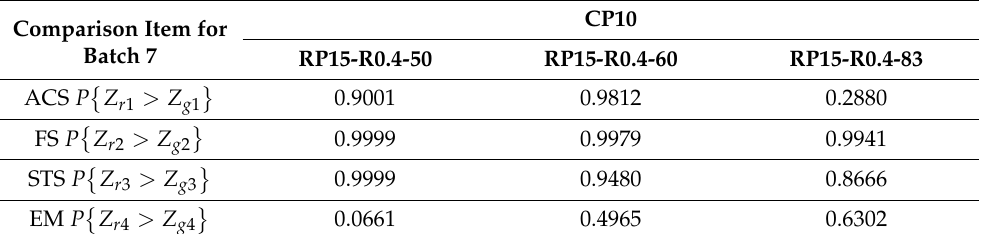
Table 13. Probability that the CVMC for steel fiber concrete is greater that of concrete used for batch 7. Comparison Item